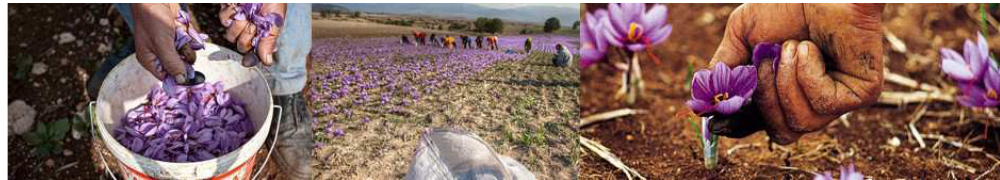
Figure 2. Saffron harvesting.